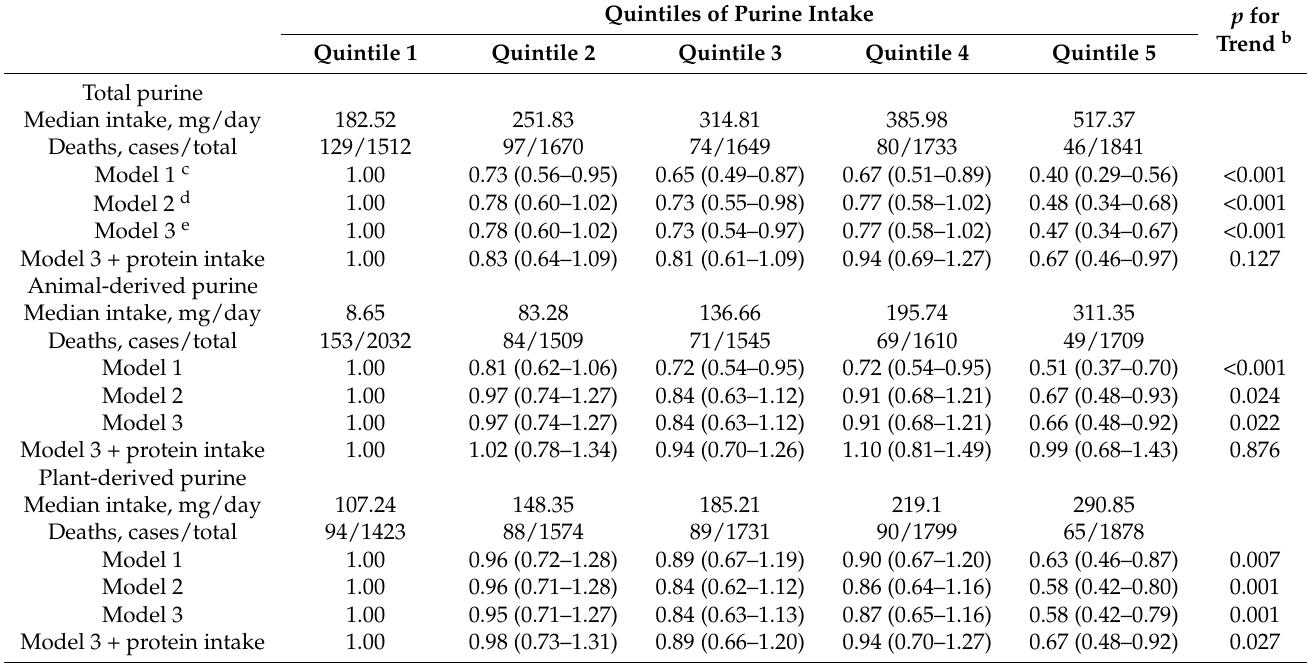
Table 3. HRs (95% CIs) of mortality according to the quintiles of purine intake in males a . Quintiles of Purine Intake p for